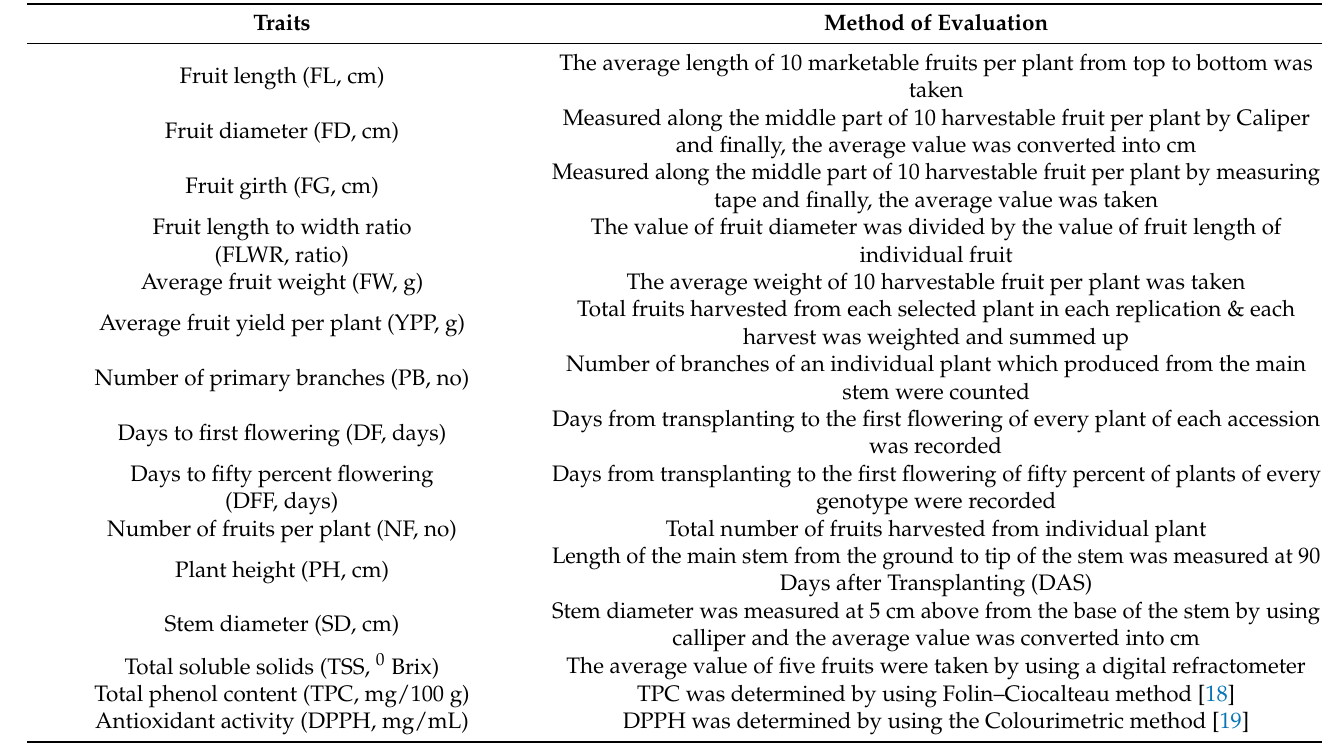
Table 2. Description of the quantitative traits measured from eggplant